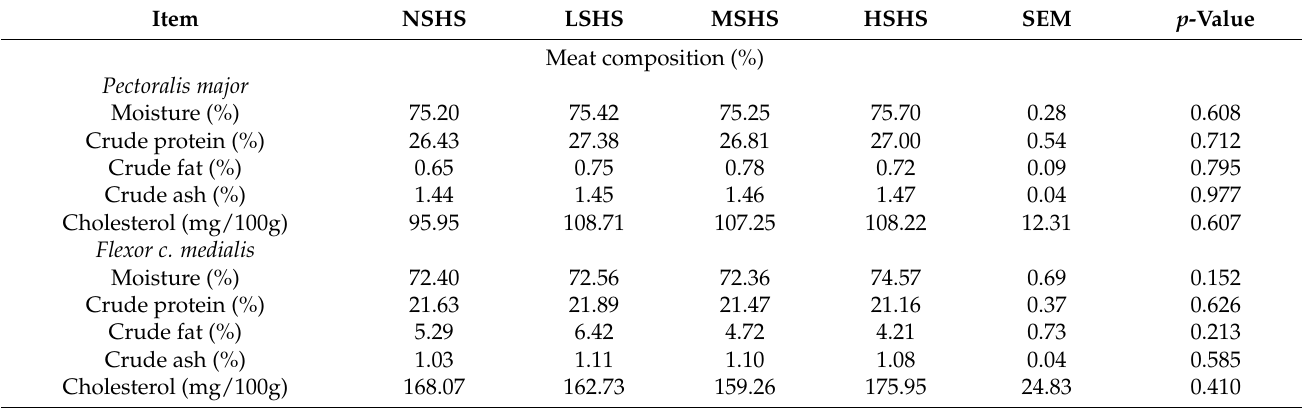
Table 2. Effects of the level of electrical stunning, halal neck cutting, and subsequent bleeding on the Pectoralis major and Flexor cruris medialis proximate composition and cholesterol content in broiler chickens.